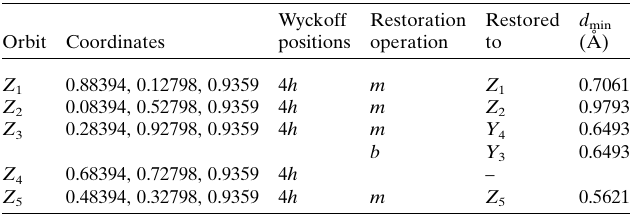
Table 5 Analysis of the split orbits Z j stemming from Z under H = P (cid:2) 44. Same conventions as in Table 3.